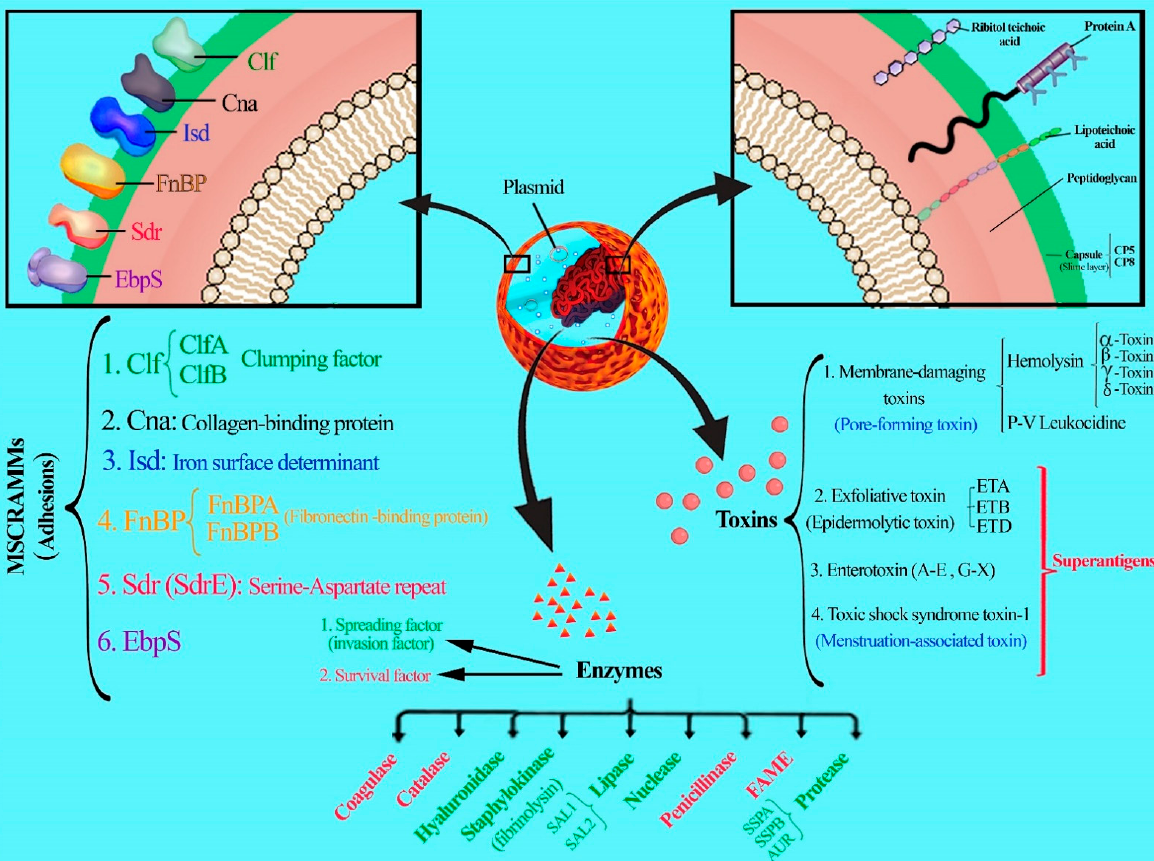
Figure 1. Diverse virulence factors of S. aureus